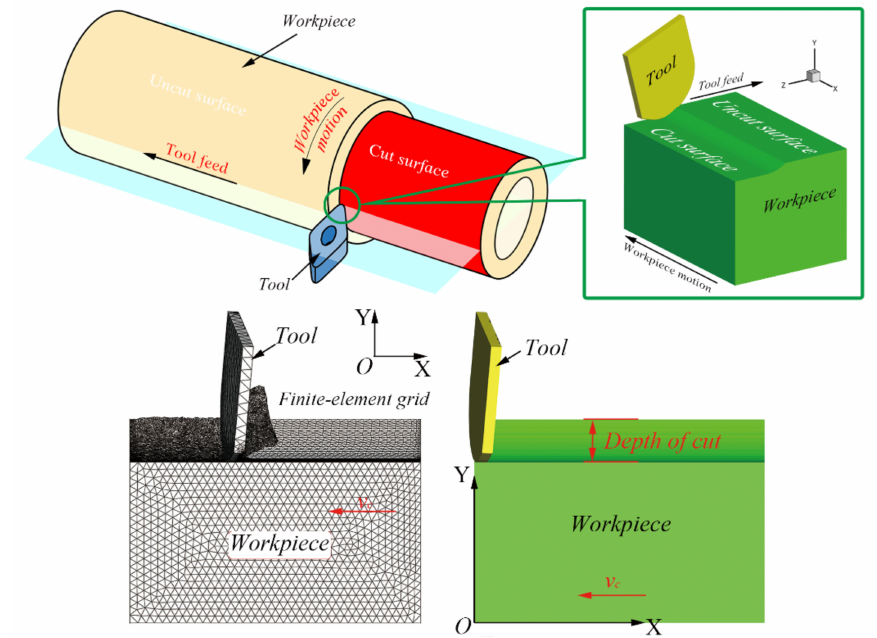
Figure 1. The 3D cylindrical turning model and boundary conditions